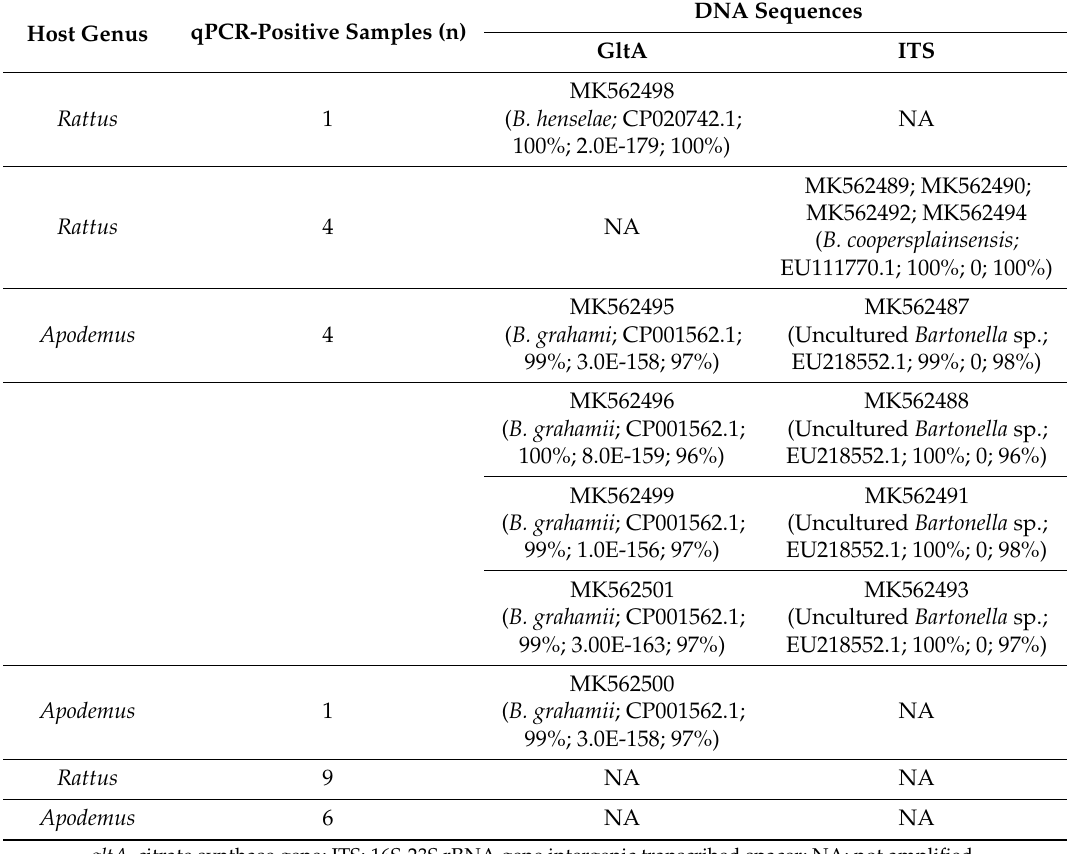
Table 1. Detailed results of the Bartonella spp. positive samples found in this study. GenBank accession numbers are reported. For each sample, the closest sequence (description, accession number, query cover %, e-value and identity %) are reported in